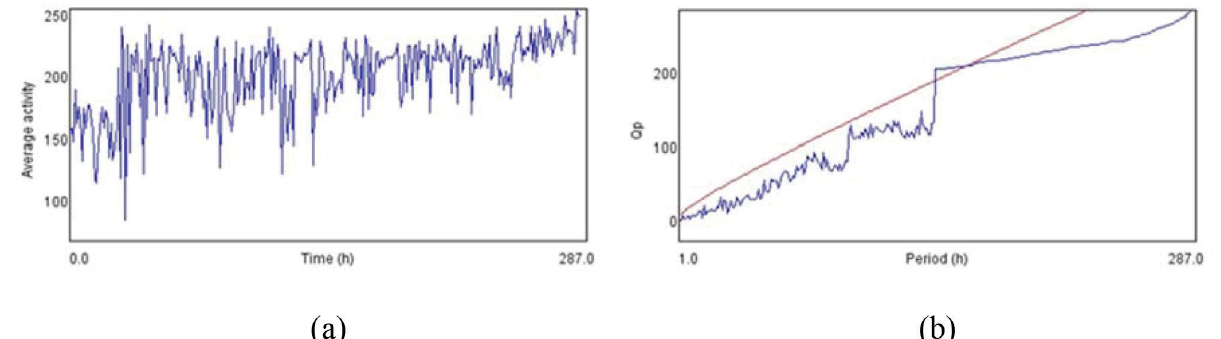
FIGURE 8S - (a) and (b) shows the average activity pattern and chi-square periodogram respectively for PD flies exposed to luteolin (100 µM).